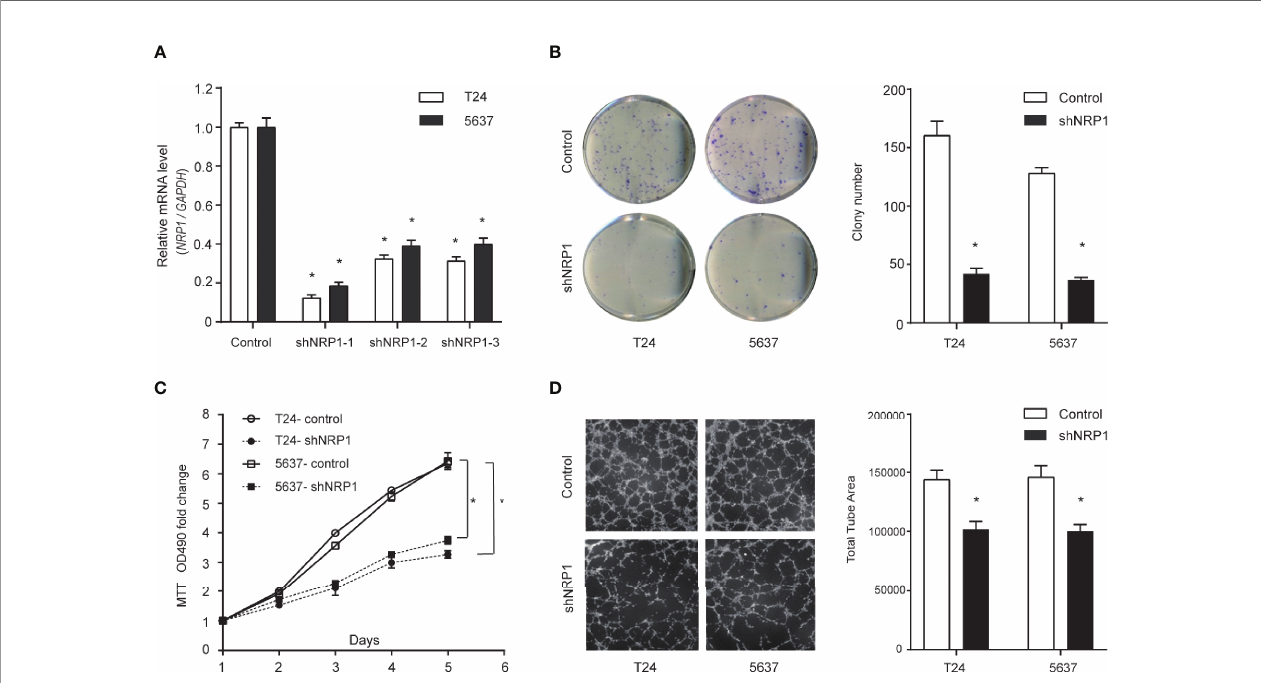
FIGURE 2 | Downregulation of NRP1 reduces BC cells proliferation and angiogenesis. (A) T24 and 5637 cells were infected with lentivirus-expressing NRP1 shRNA-1, shRNA-2, and shRNA-3, or a control shRNA; the NRP1 mRNA level as measured using qRT-PCR. (B) Downregulation of NRP1 reduced the mean colony number in the colony formation assay. (C) MTT assays revealed that downregulation of NRP1 signi fi cantly reduced the growth rate of BC cells. (D) Downregulation of NRP1 reduced tubule formation of vascular endothelial cell. Three independent experiments were conducted for each assay, and data are presented as the mean ± standard error of the mean, * p < 0.01 vs . the control